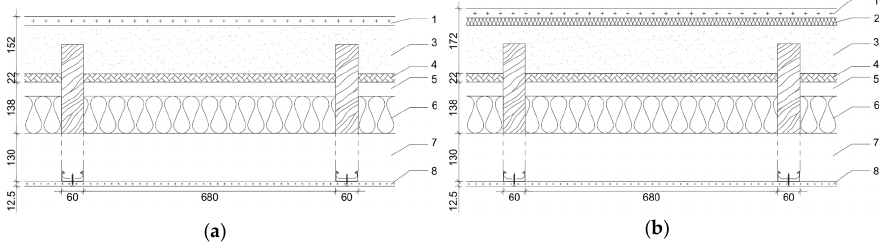
Figure 3. Cross-sections of model 1e ( a ) and 1f ( b ) of the wooden frame floor. 1 – dry screed board, 2 – mineral wool ρ = 150 kg/m 3 , 3 – expanded clay aggregate, 4 – OSB board, 5 – air gap, 6 – mineral wool ρ = 12 kg/m 3 , 7 – air gap, 8 – plaster board.